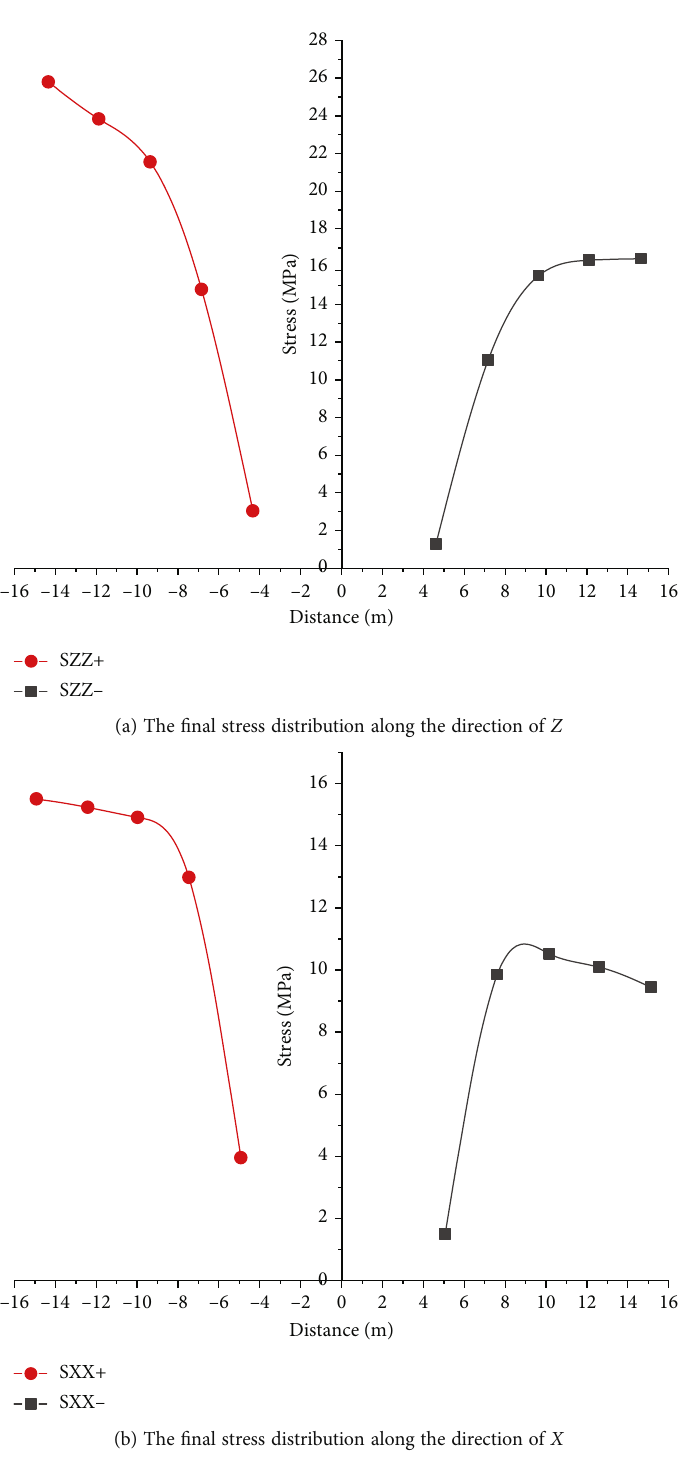
Figure 5: The equilibrium stress distribution after the roadway is